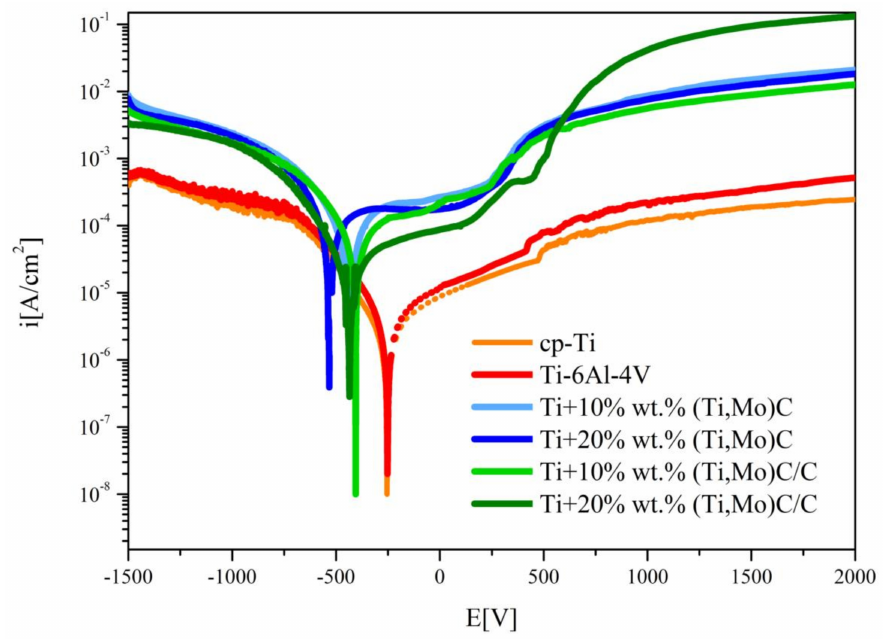
Figure 17. Comparison of the anodic polarization curves of the composites, cp-Ti, and Ti-6Al-4V